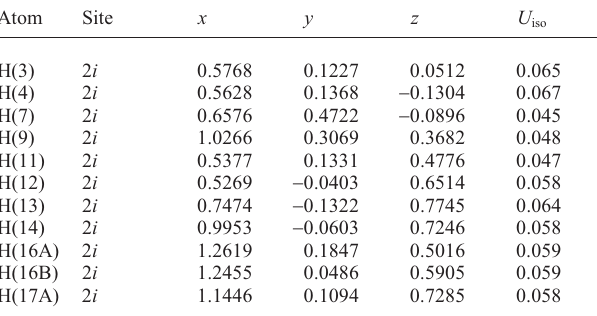
Table 2. Atomic coordinates and displacement parameters (in Å 2 )